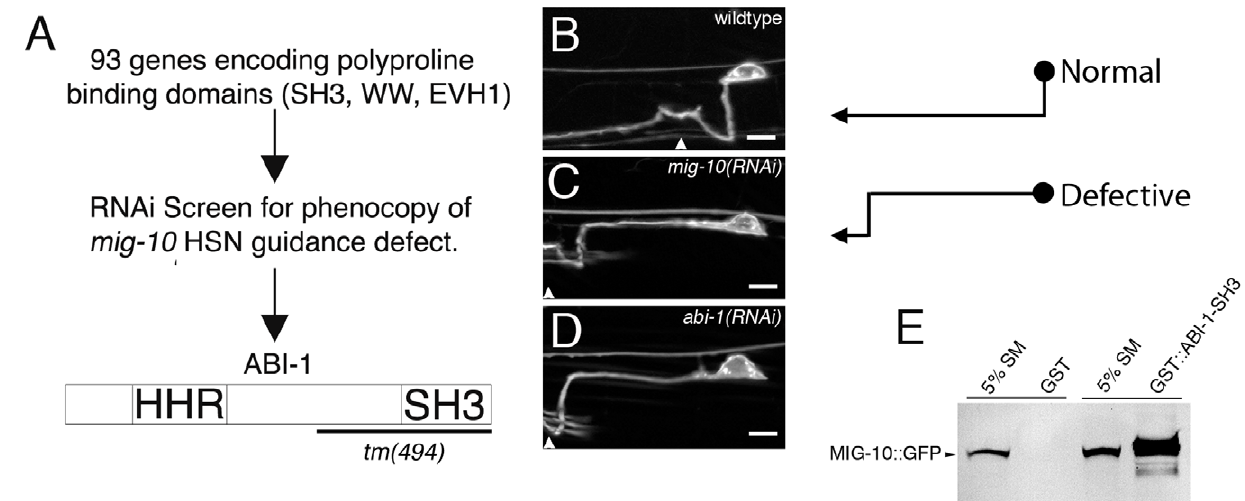
Figure 1. MIG-10 interacts physically with ABI-1. (A) Diagram of the RNAi screening strategy used to identify ABI-1. A sublibrary of RNAi clones encoding proline-binding domains (SH3, WW, EVH1) was created. Each clone was screened for the ability to phenocopy the HSN ventral guidance defect observed in mig-10 loss of function mutants. This strategy led to the identification of ABI-1 as a potential interaction partner for MIG-10. In this study we have utilized the abi-1(tm494) allele, which is predicted to truncate the ABI-1 protein as indicated by the bracket. (B) Example of HSN axon in wild-type animals. The axon makes a direct ventral migration. (C) Example of HSN ventral guidance defect observed in mig-10(RNAi) animals. The axon migrates laterally prior to turning ventrally. (D) Example of HSN ventral guidance defect observed in abi-1(RNAi) animals. The HSN axon was observed with an unc-86::myrGFP transgene. Arrowheads mark approximate position of the vulva. Note that the migration of the HSN cell body was also affected by mig-10(RNAi) and abi-1(RNAi) . However, previous analysis has indicated that HSN axon guidance defects are not secondary consequences of defects in cell body migration [18,27]. Scale bars represent 5 m m. (E) MIG-10 binds to the SH3 domain of ABI-1. MIG-10::GFP was incubated with the SH3 domain of ABI-1 fused to GST (GST::ABI-1-SH3) or GST as a control. Bound material was detected by western blotting with an antibody to GFP. For reference, an amount equivalent to 5% of the MIG-10::GFP starting material was run on a gel (5% SM).